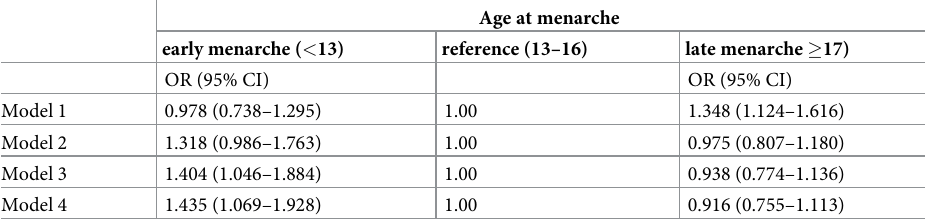
Table 3. Age at menarche and risk of diabetes mellitus.